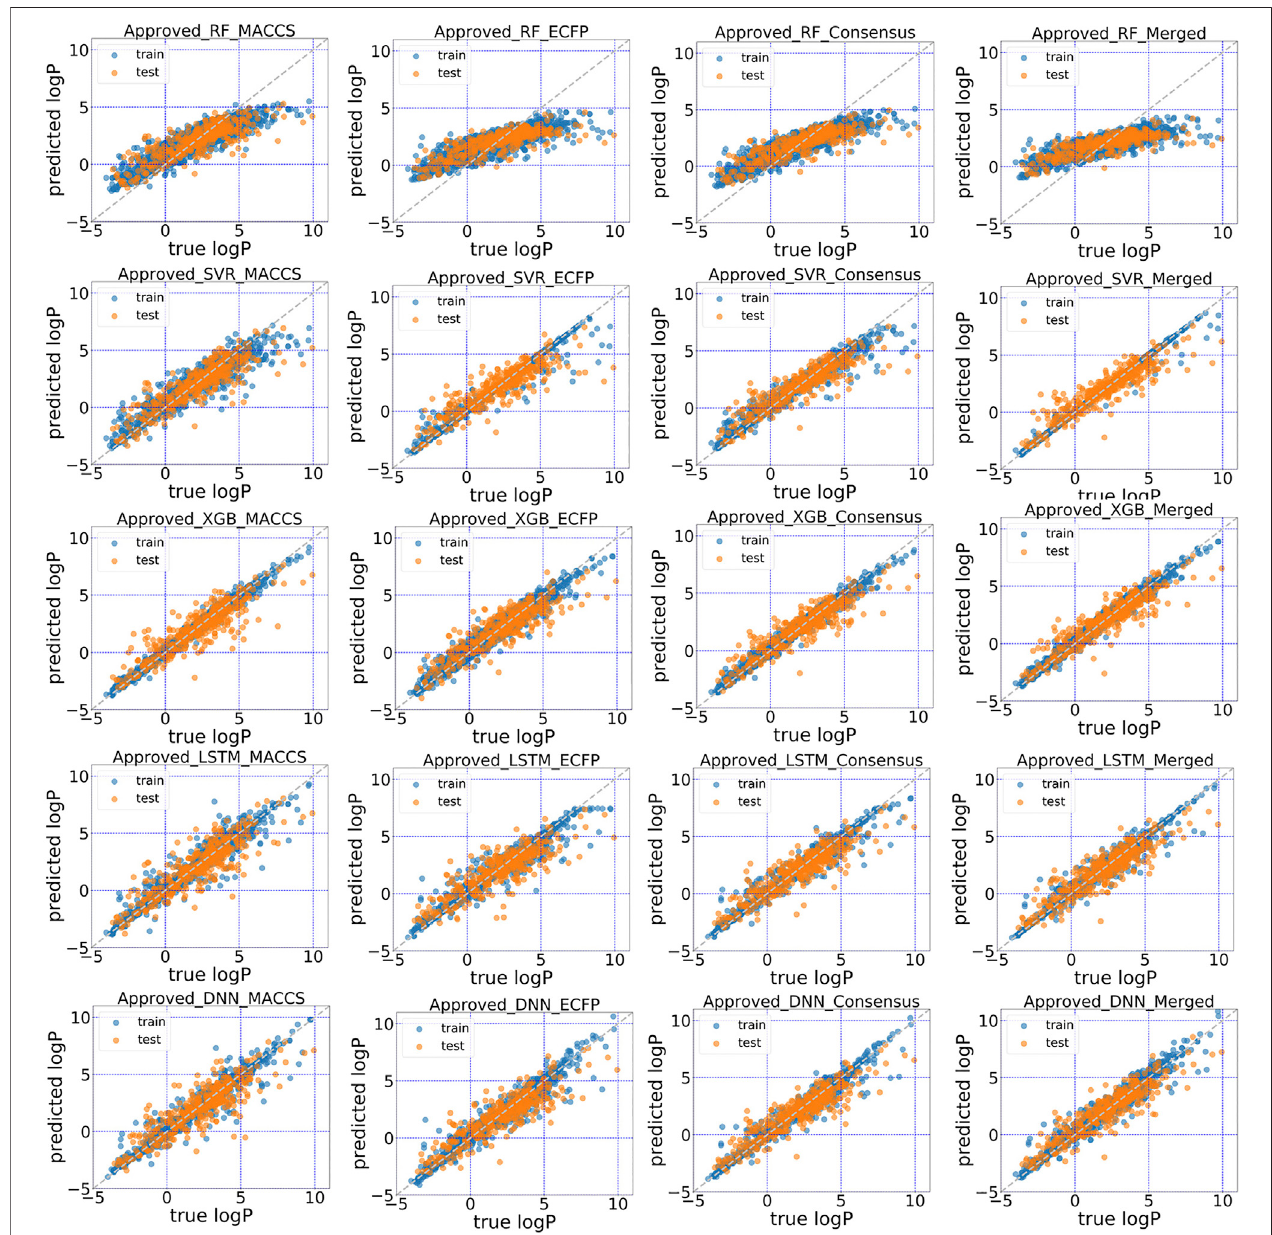
FIGURE 4 | Scatter plot of the predicted logP vs. stored data in “ Approved ” dataset of DrugBank for fi ve models with MACCS, ECFP, consensus model and the conjoint fi ngerints.